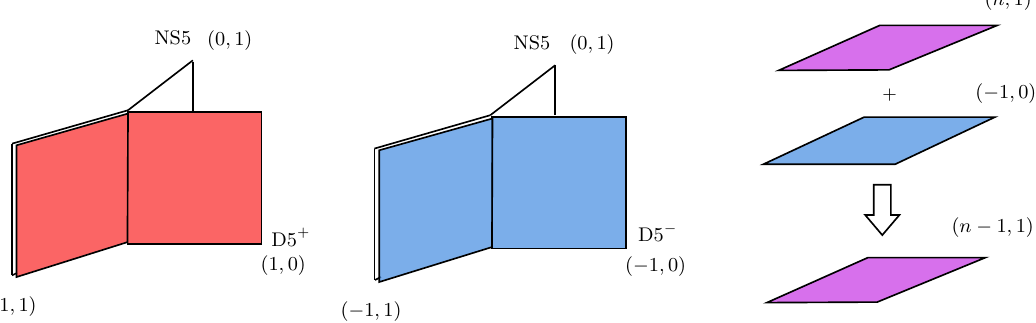
Figure 5 . Junctions of NS5-brane and positive and negative D5-branes. The charge assigned to negative D5-branes is ( − 1 , 0) which correspond to level (0 , − 1) representation. When NS5-brane intersect with a negative D5-brane, they will form a bound state with charge ( − 1 , 1) . When general ( n, 1) 5-brane intersect with a negative D5-brane, we will obtain a ( n − 1 , 1)